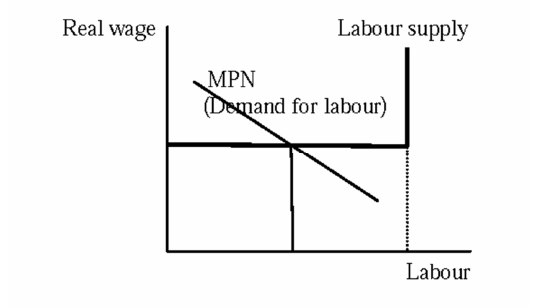
Figure 3. Pigou’s aggregate supply curve of